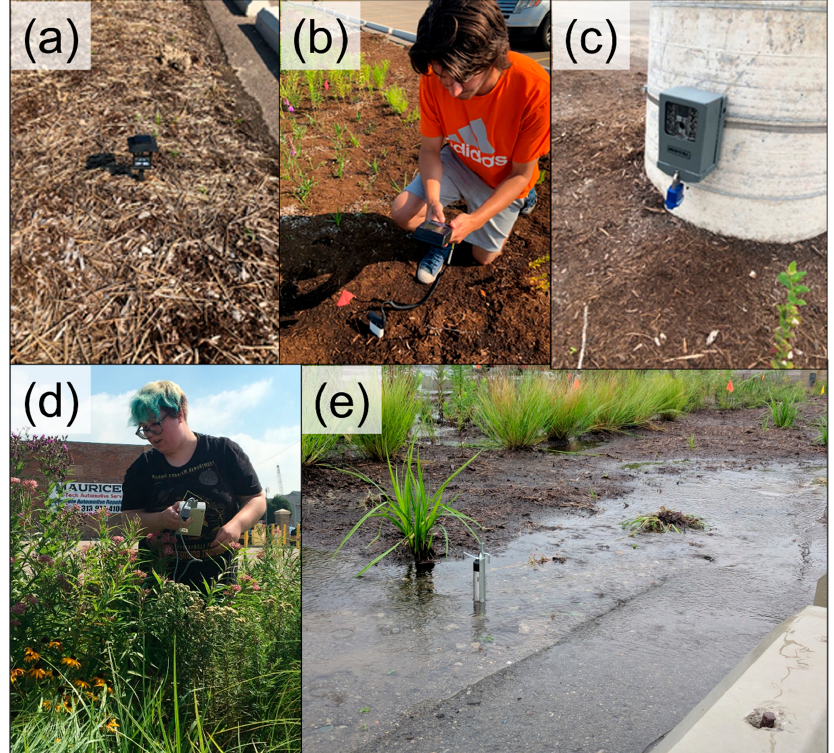
Figure 4. Site photographs of the field survey and instruments illustrating ( a ) iButtons in solar-light housing, ( b ) weekly soil moisture measurements, ( c ) a phenocam mounted on south lamppost, ( d ) weekly stomatal conductance measurements, and ( e ) a pressure transducer at one of the inputs to the bioswale after a rainstorm